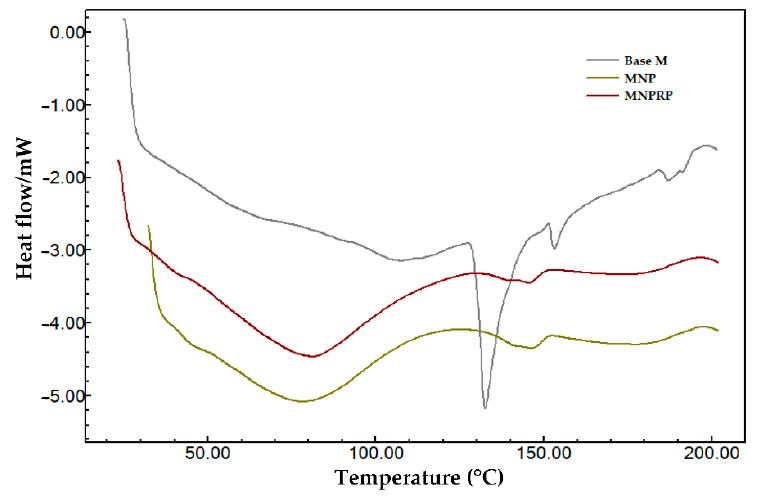
Figure 5. DSC curves of Base M (base membrane-no nanoparticles and no propolis), membrane with NPs, and membrane with NPRP.